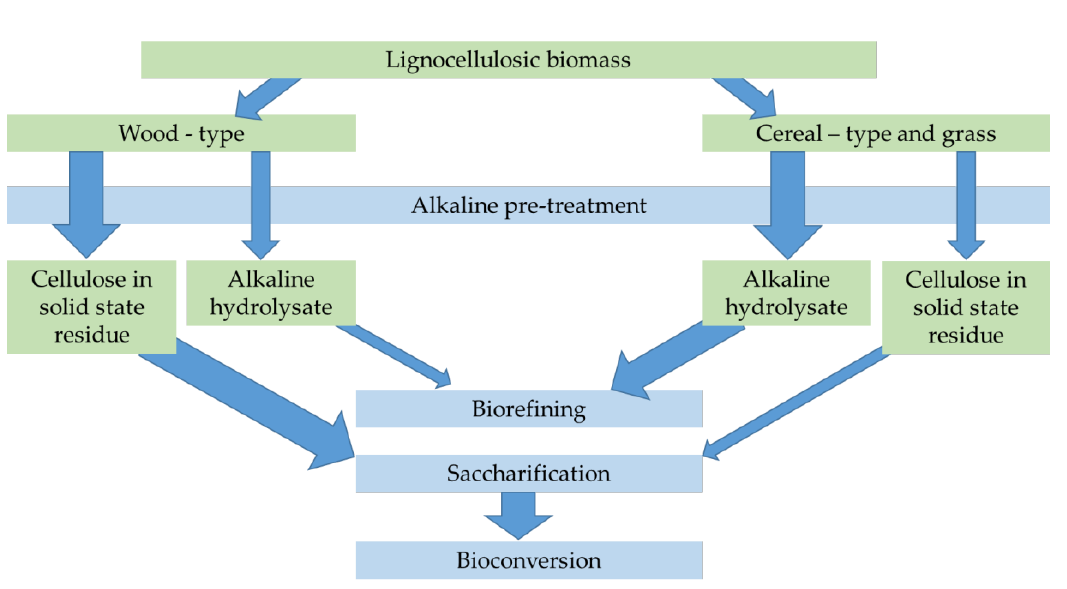
Figure 8. Possible pathways of biomass application in bioconversion and biorefining processes based on the results of the presented study.